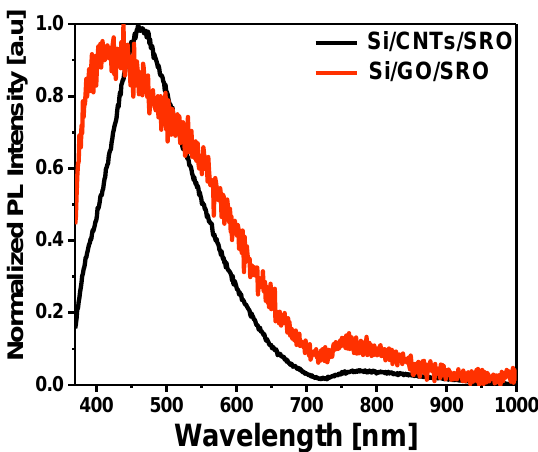
Figure 7. The normalized PL spectra of the Si-n/CNTs/SRO and the Si-n/GO/SRO structures. The broad PL spectrum suggests that multiple emission mechanisms may be involved. To find out the contributions to the PL spectra, these ones were deconvolved. The different peaks defined by the deconvolution are associated with different types of defects with their respective energy positions, as seen in Table 4. Table 4. Types of defects linked to the position [eV] of the PL peaks of the structures.